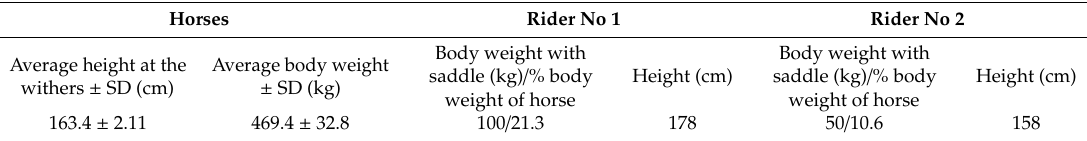
Table 1. Biometric profiles of the horses and riders involved in the study. Horses Rider No 1 Rider No 2 Body weight with Average height at the Average body weight saddle (kg) / % body ± SD (kg) withers ± SD (cm)